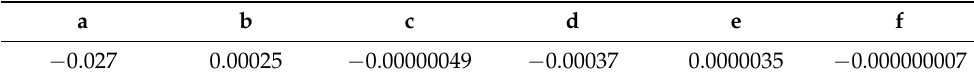
Table 2. Values of the coefficients for storm surge estimation in Mazatlan.